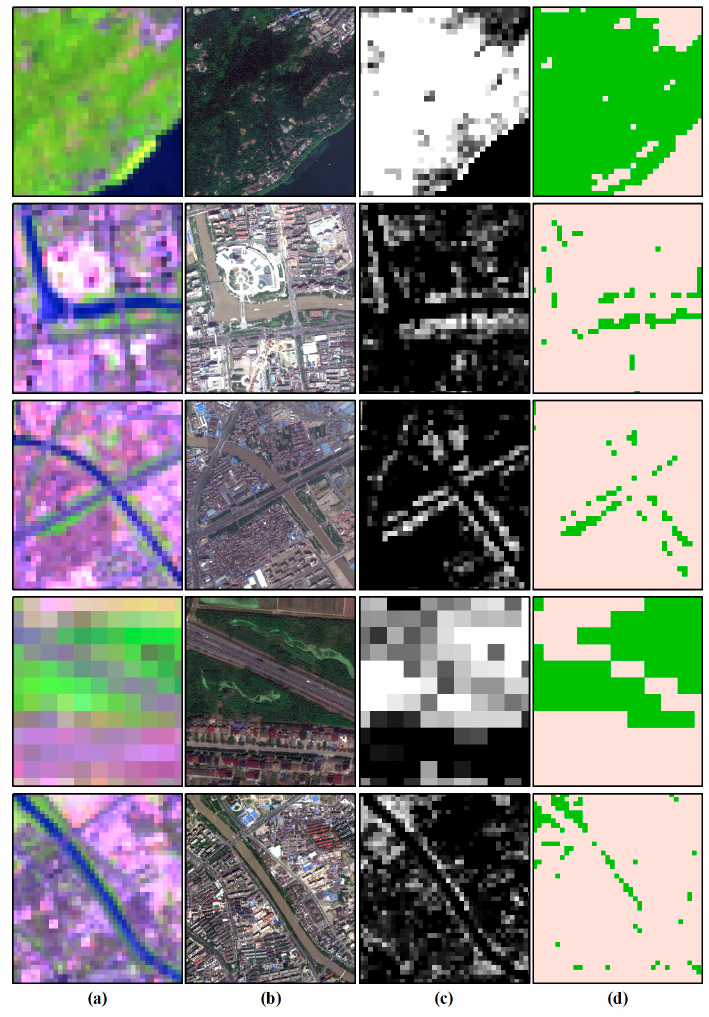
Figure 3. Comparisons between results from multiple endmember spectral mixture analysis (MESMA) and traditional pixel-based classification in 2013: ( a ) Landsat 8 OLI (RGB: 654; July 19, 2013); ( b ) high-resolution color-composition aerial photographs (August 17, 2013); ( c ) vegetation fraction from MESMA; and ( d ) vegetation classification result from SVM.